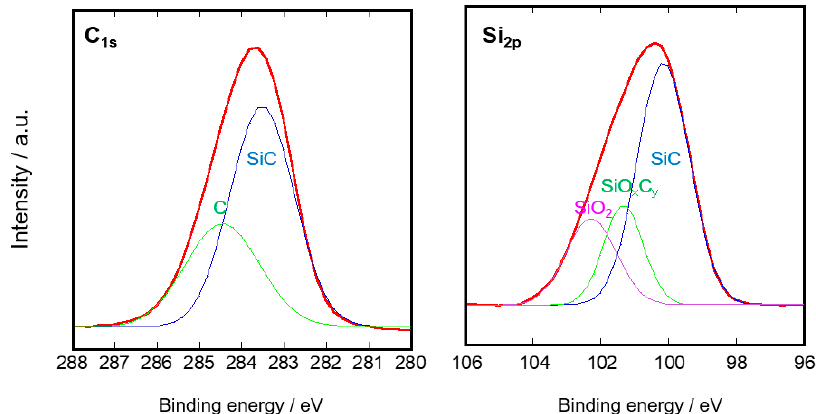
Figure 7. Result of XPS analysis for SiC / Ni- γ -Al 2 O 3 / α -Al 2 O 3 membrane.